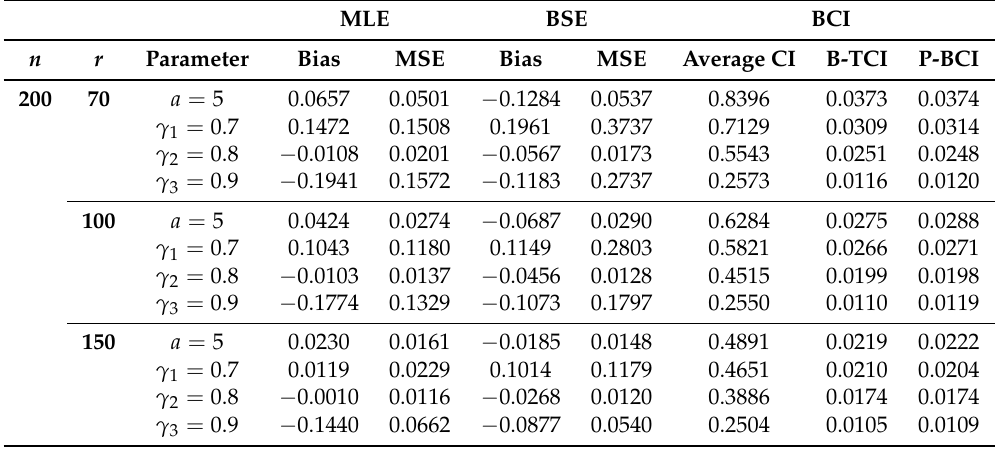
Table 4. Estimation summaries for the BBXEx model based on Type-II censored data at n = 200. MLE BSE